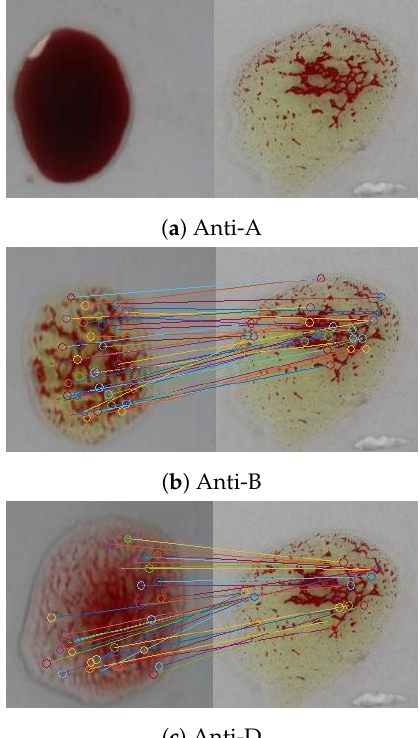
Figure 18. Feature points matching between a blood sample the reference image for the three blood spots (anti-A, anti-B, and anti-D) using the SURF